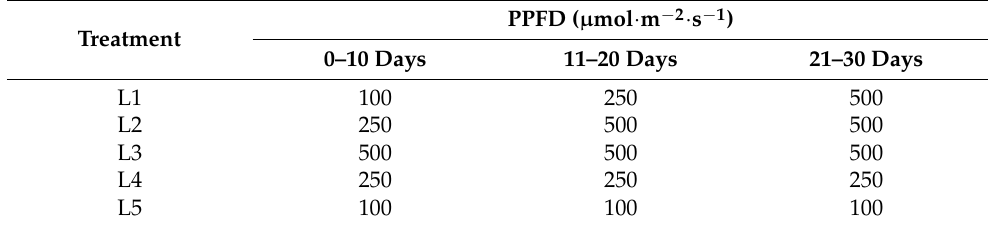
Table 3. Regulations of light intensity treatments on apple seedlings.